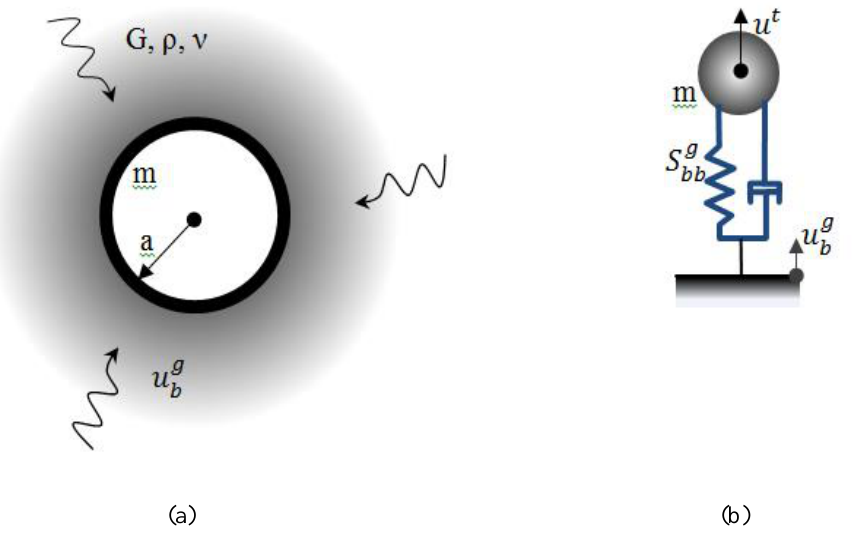
Figure 2. (a) and (b) Mass attached to spherical cavity and its idealized SDOF